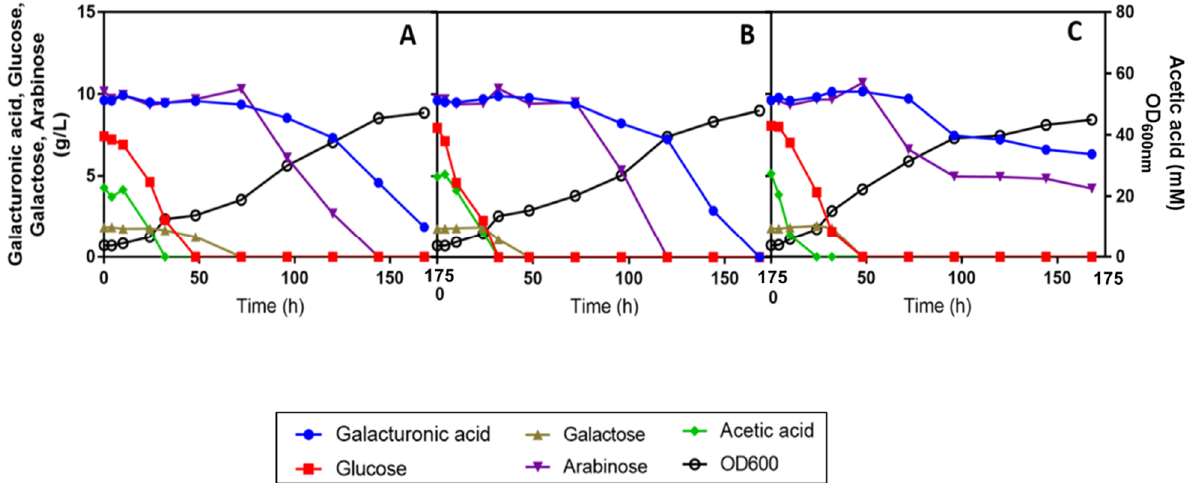
Figure 6. Effect of different initial concentrations of ammonium sulphate, ( A ) 5, ( B ) 2.5 and ( C ) 1 g/L, on the utilization of the different carbon sources present in SBP hydrolysate H13 during the cultivation of R. toruloides PYCC 5615. The sugar beet pulp hydrolysate H13 medium at pH 5.0 was prepared in YNB supplemented with the amino acids present in commercial YNB besides the different ammonium sulphate concentrations to be tested. Cultivations were performed at 30 ◦ C, with orbital agitation (250 rpm). Inoculation was with an initial OD 600 nm of